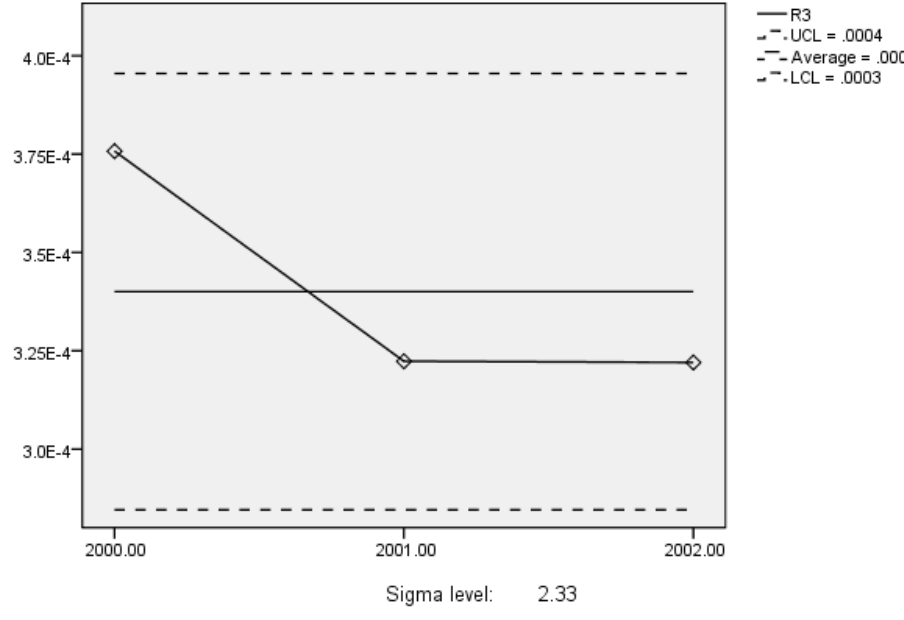
Agronomy 2021 , 11 , x Figure 1. R(3) control chart for the Philippines. Figure 1. R(3) control chart for the Philippines.